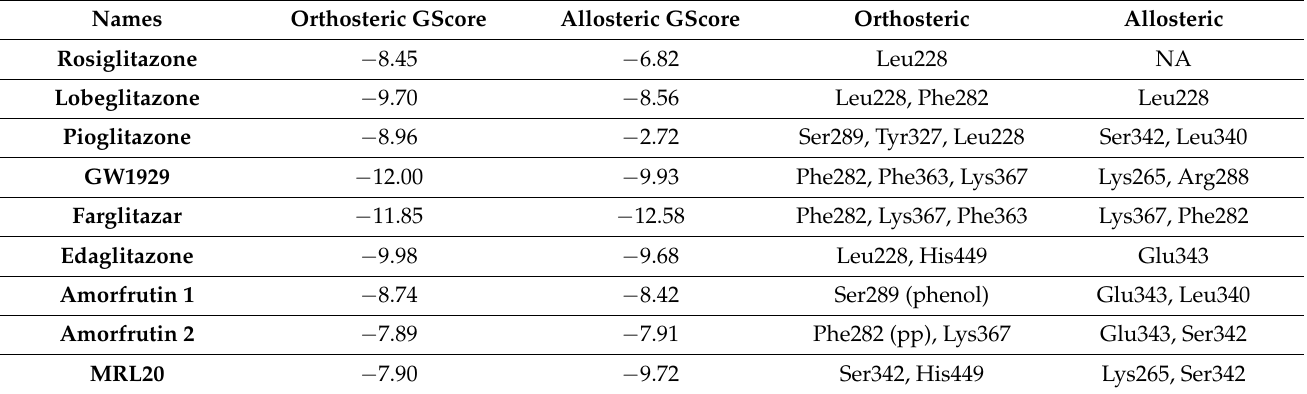
Table 5. The glide scores (kcal/mol) and interacting residues for the nine PPAR γ agonists against the allosteric and orthosteric binding